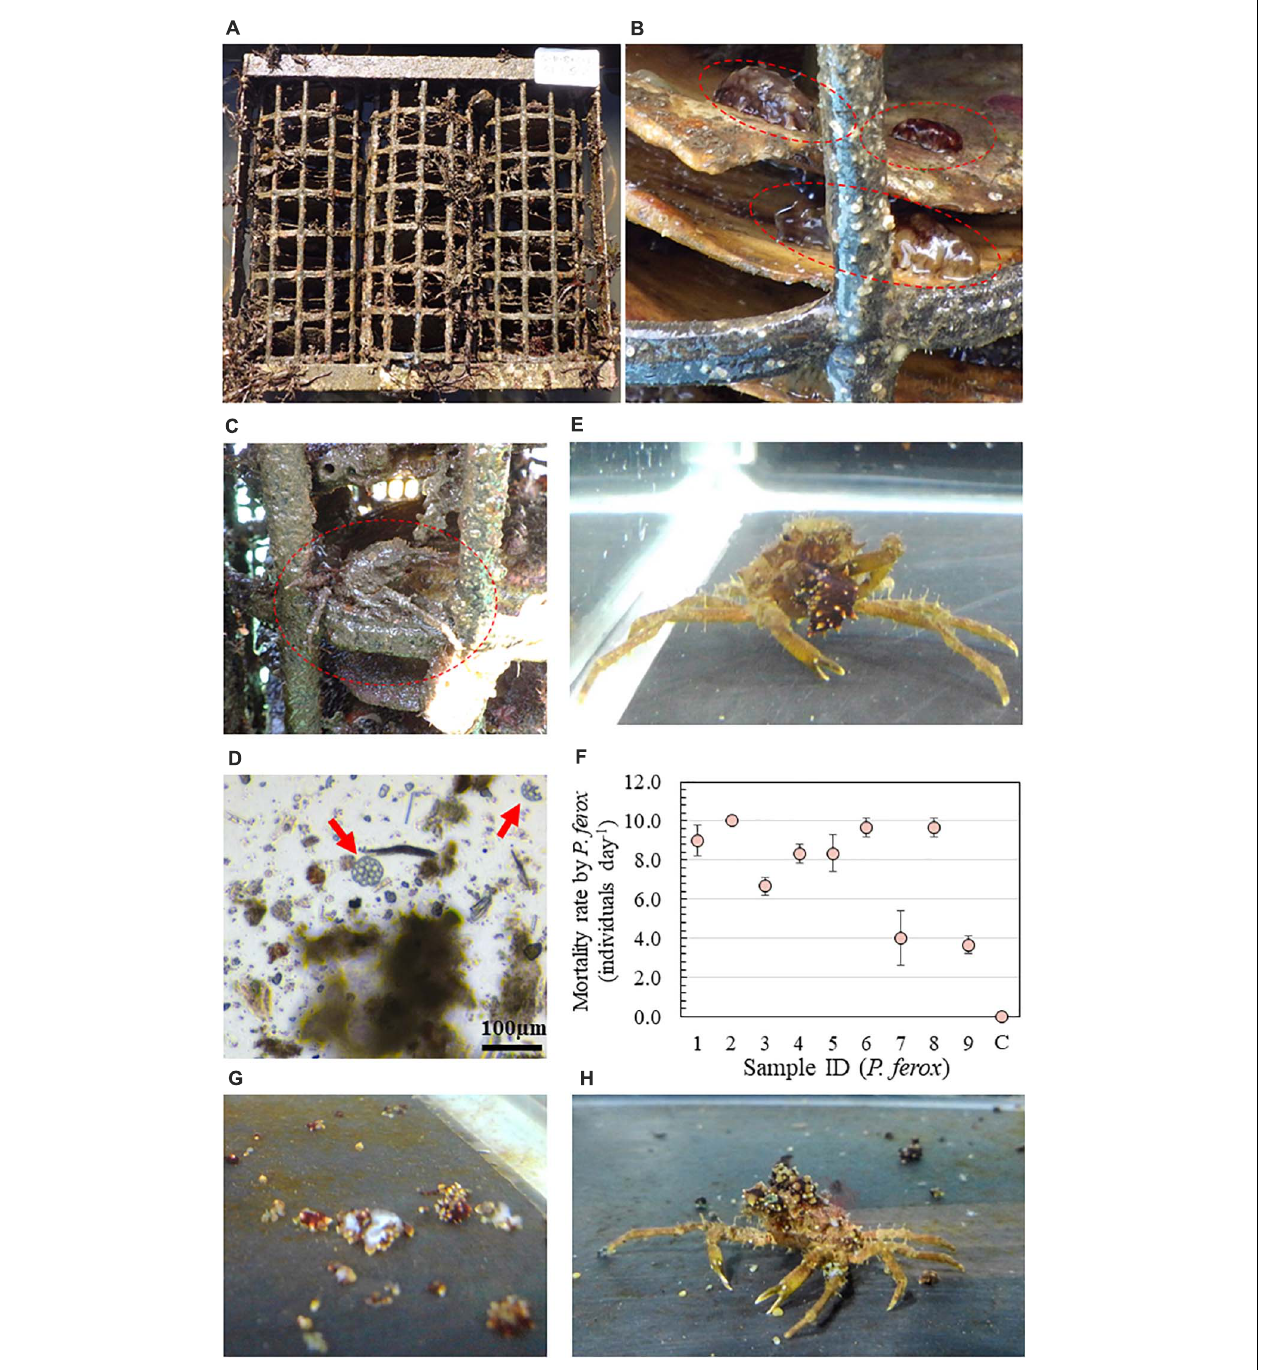
FIGURE 1 | (A) An artificial intermediate sea cucumber reef for releasing hatchery-produced juvenile Apostichopus japonicus . (B) Attached juvenile A. japonicus ( (cid:13) ) on scallop shells as a substrate within the reef. (C) Observed Pugettia ferox ( (cid:13) ) within the same reef. (D) Ossicles of A. japonicus detected from the stomach contents of P. ferox . (E) Active predation of juvenile A. japonicus by P. ferox . (F) Results of the laboratory predation experiments. An aquaria with no P. ferox was used as a control (C). (G) Picture of A. japonicus killed by a female P. ferox within the first 2 h. (H) Decoration of P. ferox using pieces of chopped sea cucumber.